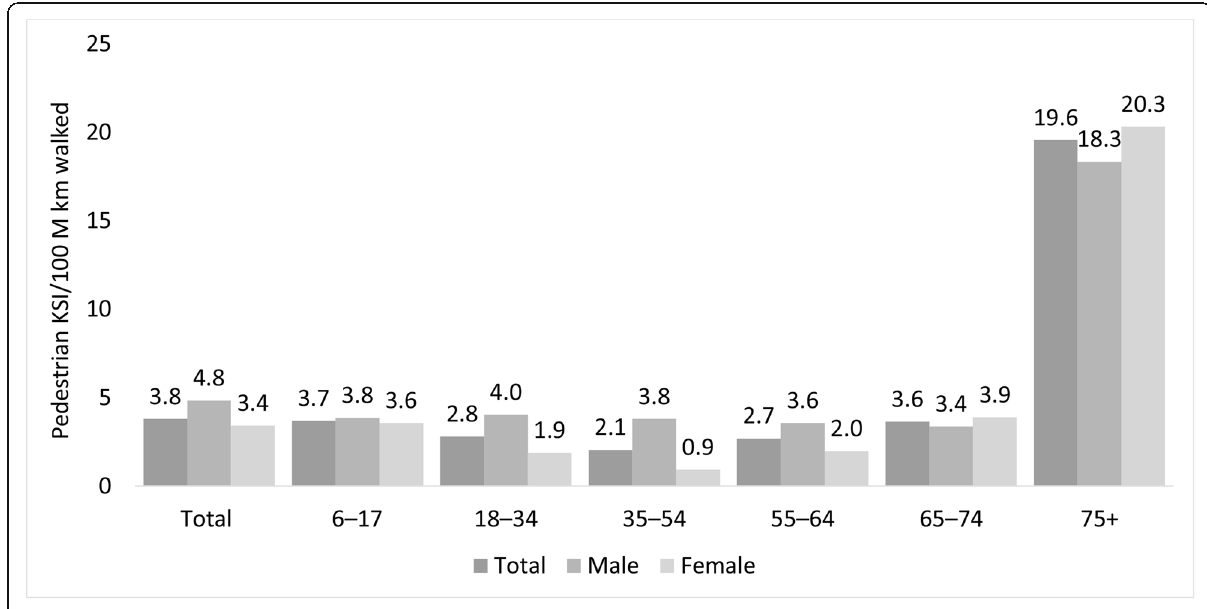
Fig. 2 Pedestrian KSI rate according to gender and